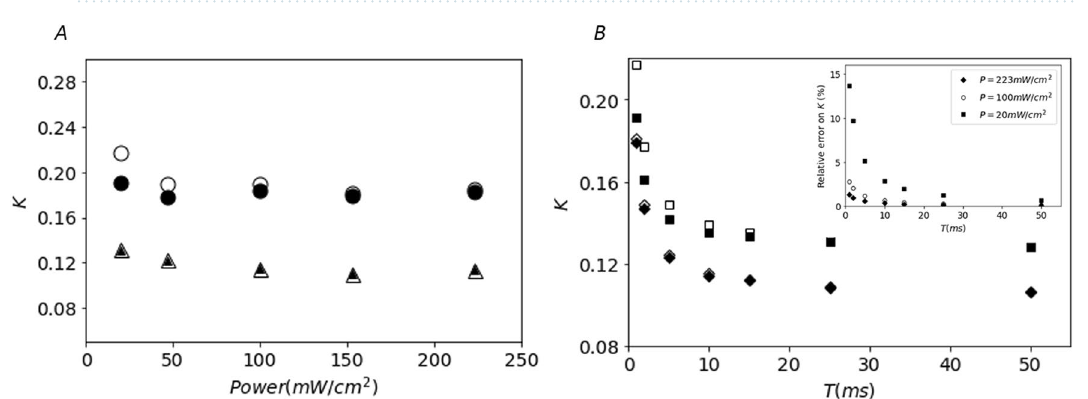
Figure 3. Effect of illumination level and exposure time on the shot noise contribution to the speckle contrast in synthetic exposure mode. ( A ) Effect of the detected light intensity; empty dots (raw contrast K raw ) and filled dots (noise corrected contrast K corr ) correspond to an exposure time of 1 ms; empty triangles ( K raw ) and filled triangles ( K corr ) correspond to an exposure time of 25 ms. ( B ) Effect of the exposure time; empty squares ( K raw ) and filled squares ( K cor r ) correspond to an illumination of 20 mW/cm 2 ; empty diamonds ( K raw ) and filled diamonds ( K corr ) correspond to an illumination of 223 mW/cm 2 . Insert: Relative error due to the shot noise speckle contrast as a function of exposure time for different illumination levels; squares, dots and diamonds correspond respectively to illuminations of 20, 100 and 223 mW/cm 2